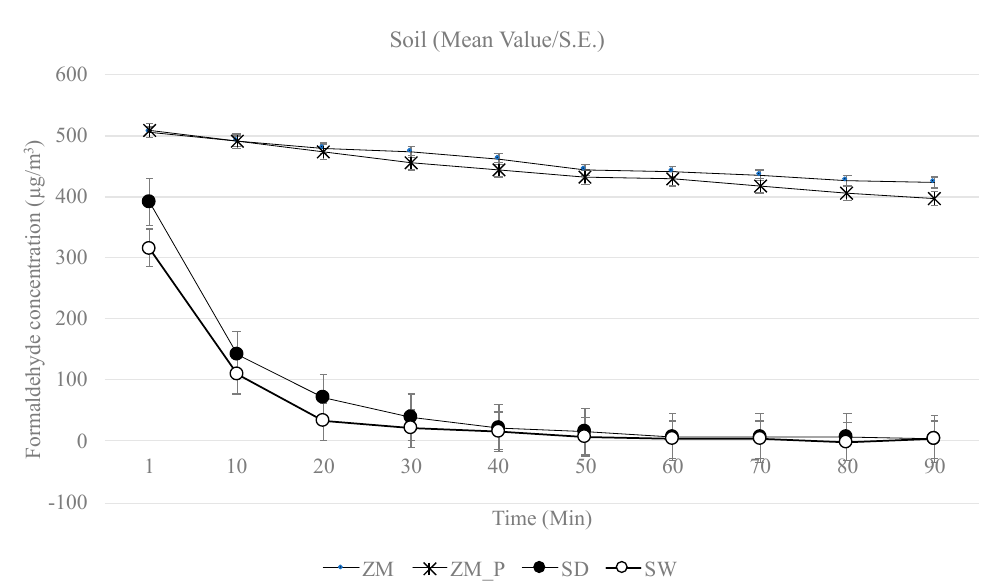
Figure 5. Measured formaldehyde concentration (( µ g/m 3 )/h) when soil samples were tested: zero measurement (ZM1), zero measurement with the plastic pot (ZM_P), dry soil (SD), wet soil (SW). Data means ± SE, n = 3. Activated Carbon (Mean Value/S.E.)